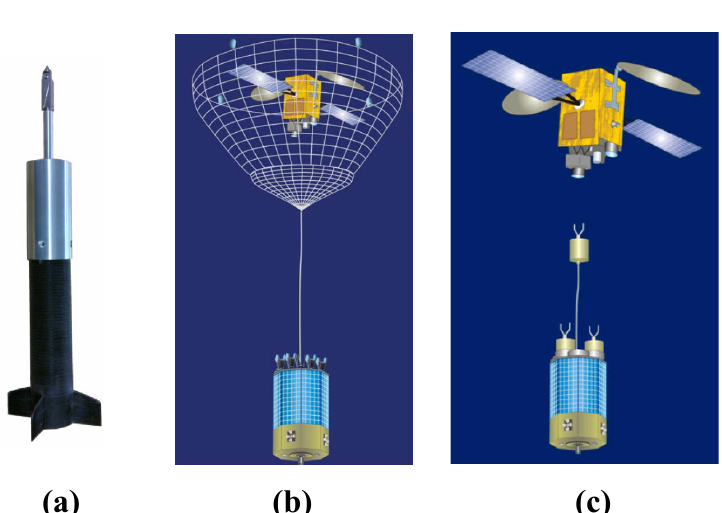
Figure 2. Flexible connection capture methods. ( a ) Harpoon method [4], ( b ) net method [5], ( c ) tether– gripper method